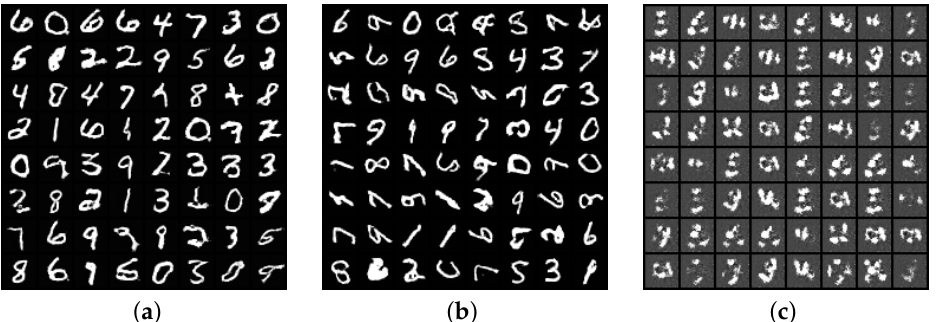
Figure 1. GAN output for detecting unwanted rotations on MNIST. ( a ) Trained on correct images with BDP; ( b ) Trained on altered images with BDP; ( c ) Trained on altered images with DP.